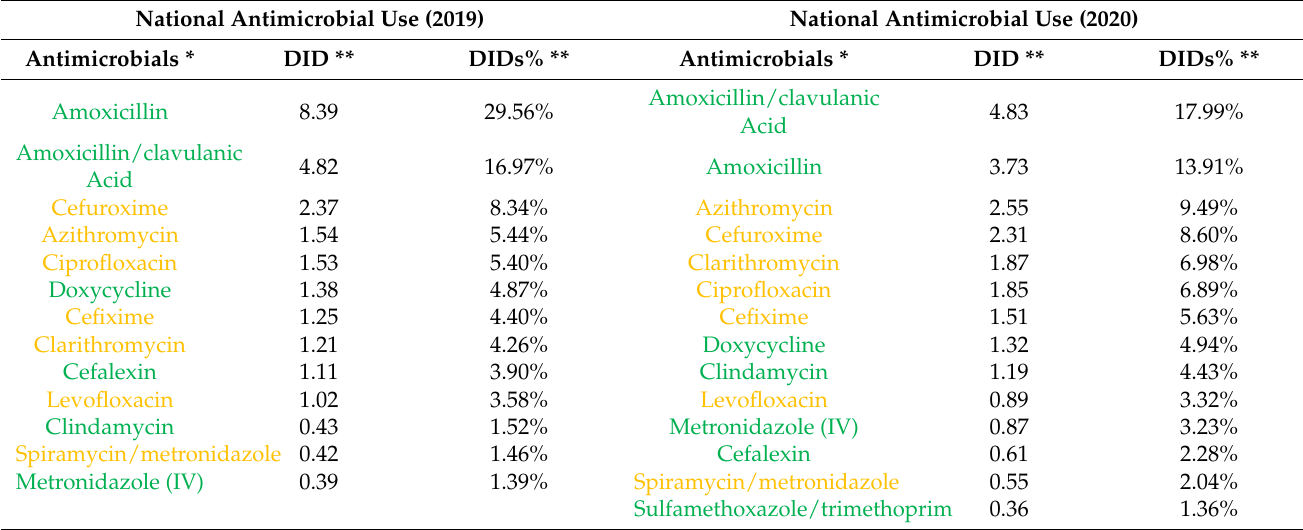
Table 3. National antimicrobial consumption, contributing to 90% of total national antibiotic use in 2019 and 2020, and categorized by WHO AWaRe category (Access/Reserve/Watch).